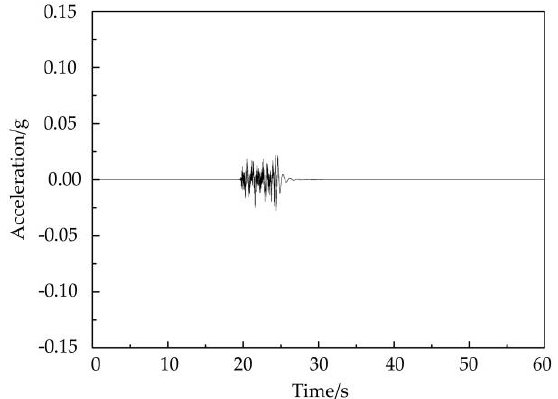
Figure 9. Typical vertical acceleration of Segment 1 in the current monitoring stage.